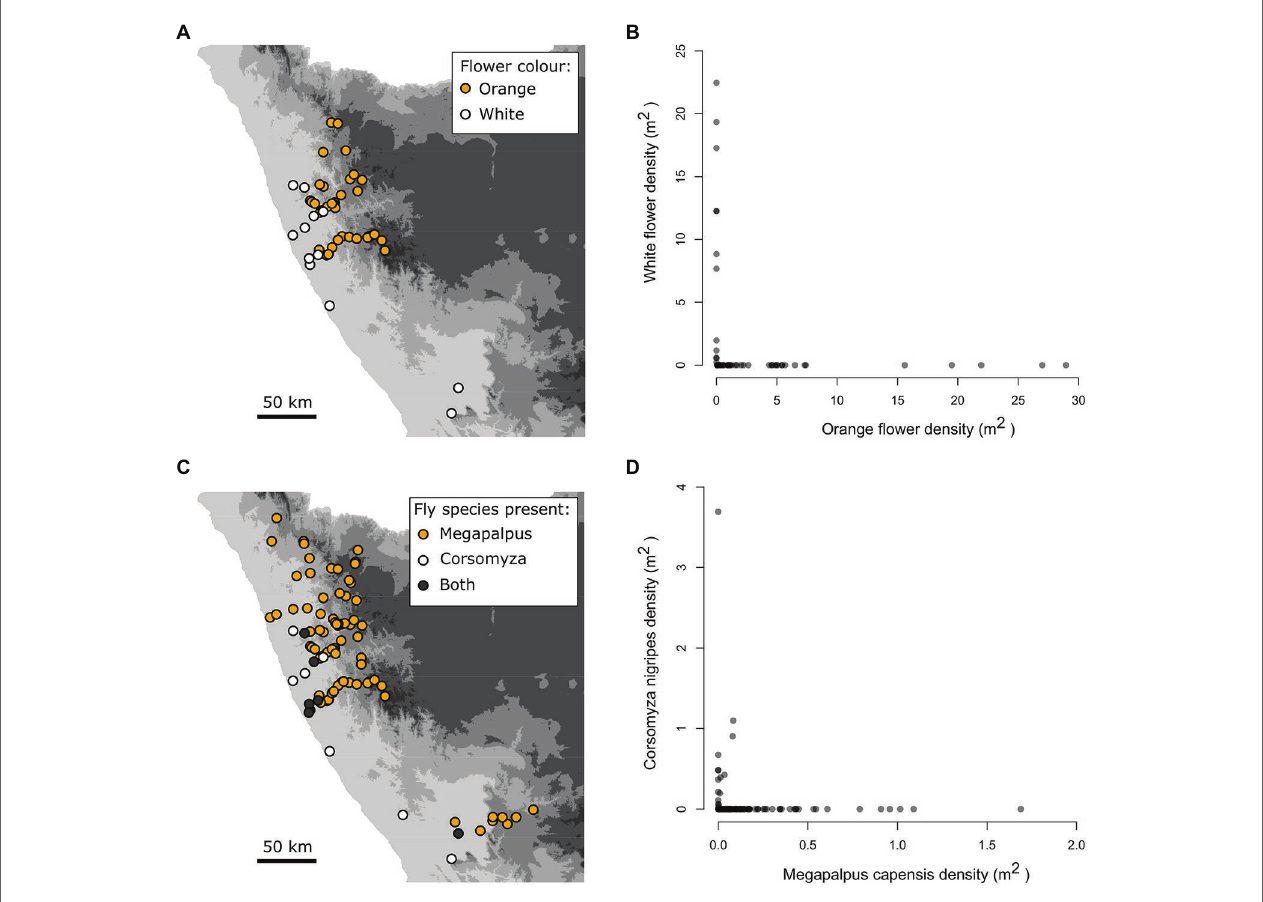
FIGURE 2 | Strongly aligned spatial gradients of flower color and pollinators of annual daisy species across the Namaqualand landscape. The non-overlapping distribution (A) and density relationships (B) of the focal orange ( Dimorphotheca sinuata , Ursinia cakelifolia ) and white ( Dimorphotheca pluvialis , Ursinia speciosa ) flowered species at 54 sites. The geographic mosaic (C) and density relationships (D) of the dominant bee-fly pollinators, Megapalpus capensis , and Corsomyza nigripes , across 103 survey